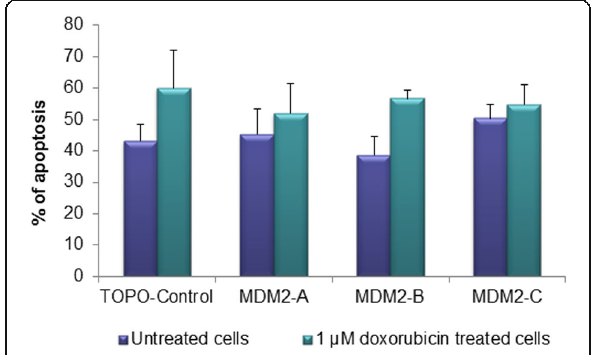
Fig. 5 Induction of apoptosis. Graphs show the percentage of apoptotic cells after transfection with pCMV (TOPO-Control) and the splice variants. Untreated cells ( purple bars ) and cells treated with 1 μ M doxorubicin ( green bars ) were analyzed by AnnexinV assay 48 h post transfection. Each pillar represents the total of apoptotic and early apoptotic cells. The experiment was repeated in triplicate with three independent